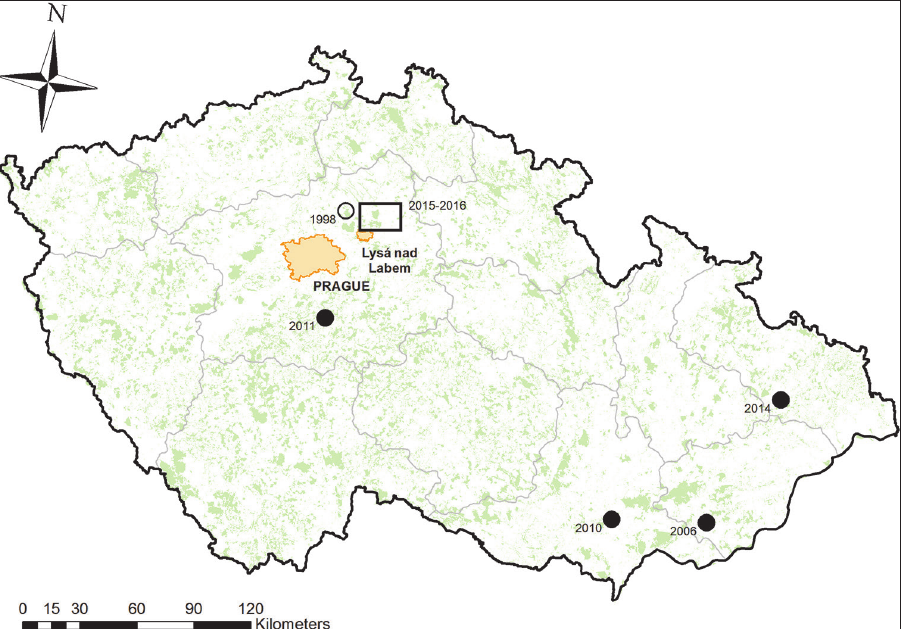
Figure 1. Location of the study area in central Bohemia, western part of the Czech Republic (black rectangle). Previous records relating to dead animals (solid circles), and the first unconfirmed observation (empty circle) are also shown. The records are given by the year of observation, see details in Table